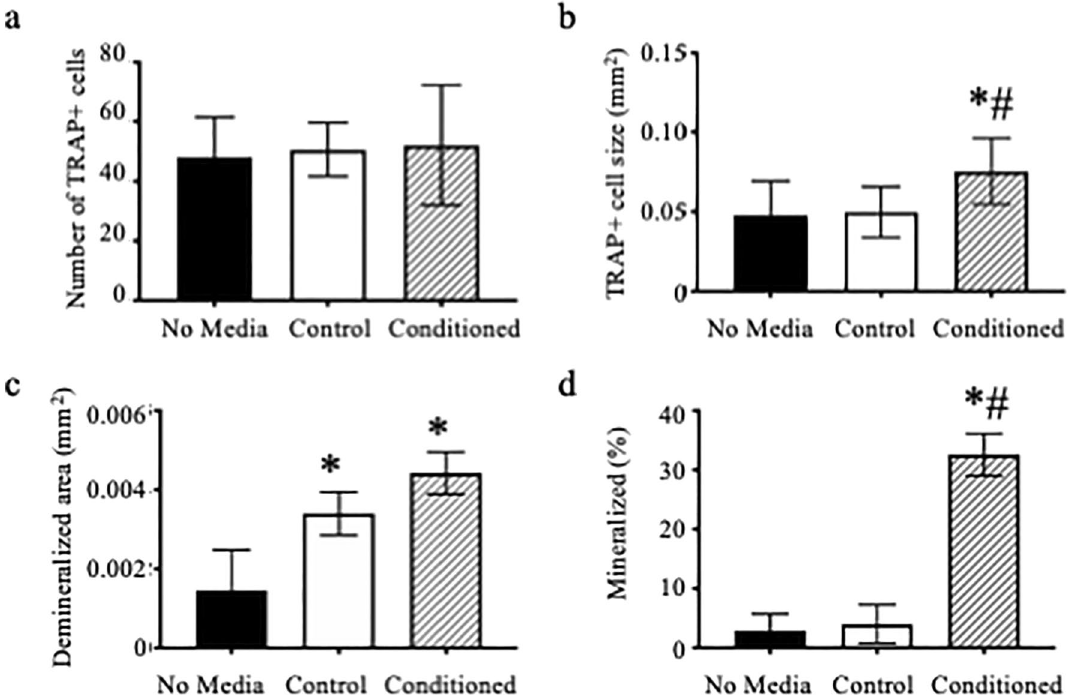
Figure 1. Muscle conditioned media enhances osteoclast and MC3T3 activity. ( A – C ) Bone marrow macrophages were treated with M-CSF and RANKL to induce osteoclast differentiation. At the time of RANKL addition, cultures were also given no media, Krebs media not exposed to muscle (Control) or muscle conditioned media, with the volume of the latter two conditions equal to 5% of the total media. ( A ) Average number and ( B ) average size of TRAP positive multinuclear cells and ( C ) average size of demineralized area. ( D ) MC3T3-E1 cells were grown to confluency and then induced to differentiate with the addition of ascorbic acid. Krebs (Control) or muscle conditioned media was given at the same time as ascorbic acid. Von Kossa assay was performed to determine percent mineralization. *Significantly different from No Media; # Significantly different from